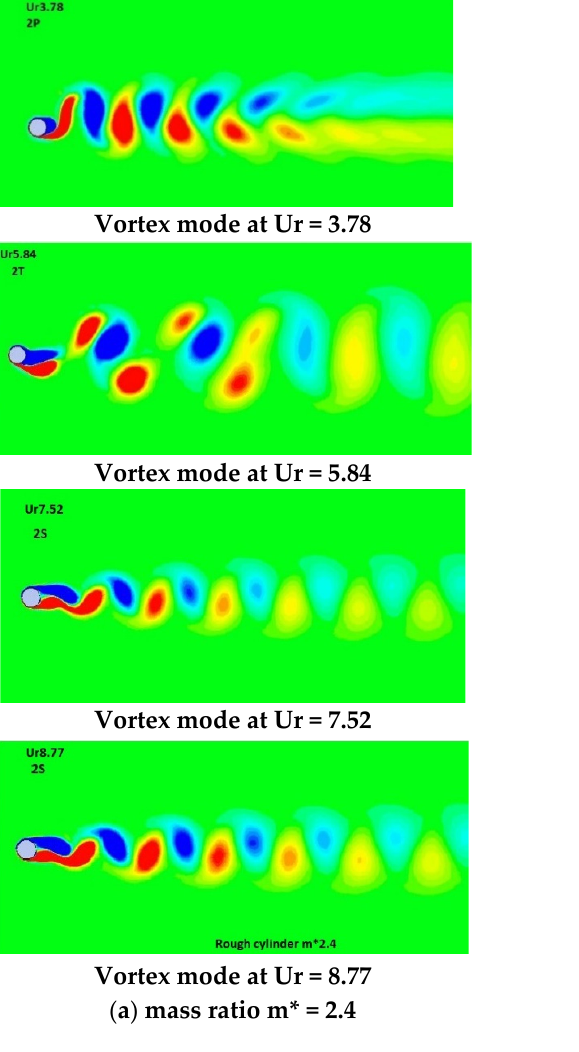
Figure 6. Vortex mode at different reduced velocities with roughness Ks = 0.02 D: ( a ) m* = 2.4 and ( b ) m* = 11.